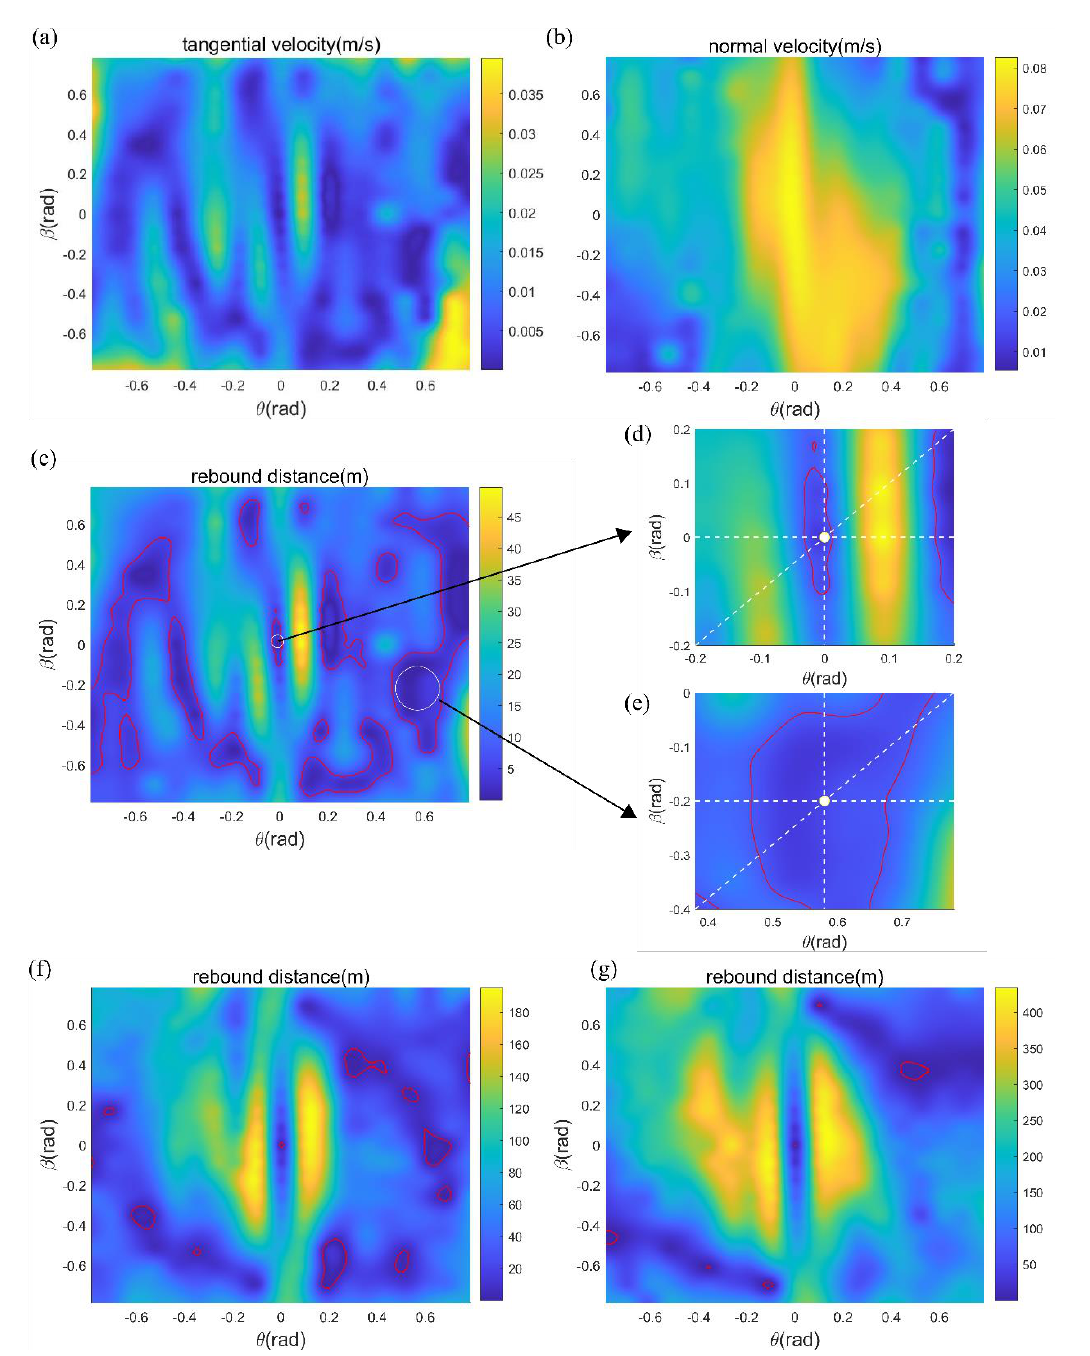
Figure 12. ( a ) The flexible lander’s tangential velocity after the first collision at v 0 = 0.1 m/s ; ( b ) the flexible lander’s normal velocity after the first collision at v 0 = 0.1 m/s; ( c ) the flexible lander’s rebound distance at v 0 = 0.1 m/s; ( d ) local amplification of the origin in Figure 4c; ( e ) local amplification of α = 0.58, β = − 0.2 in Figure 4c; ( f ) the flexible lander’s rebound distance at v 0 = 0.2 m/s; ( g ) the flexible lander’s rebound distance at v 0 = 0.3 m s.